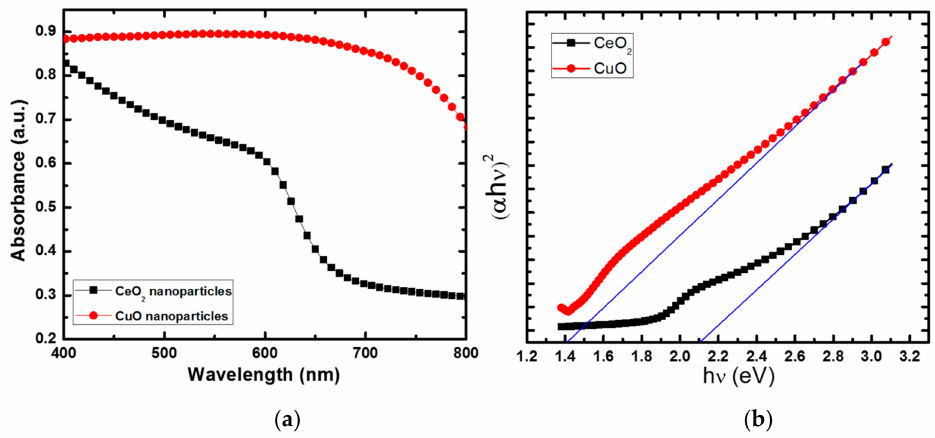
Figure 6. ( a ) Absorbance spectra and ( b ) Kubelka–Munk plot of CuO and CeO 2